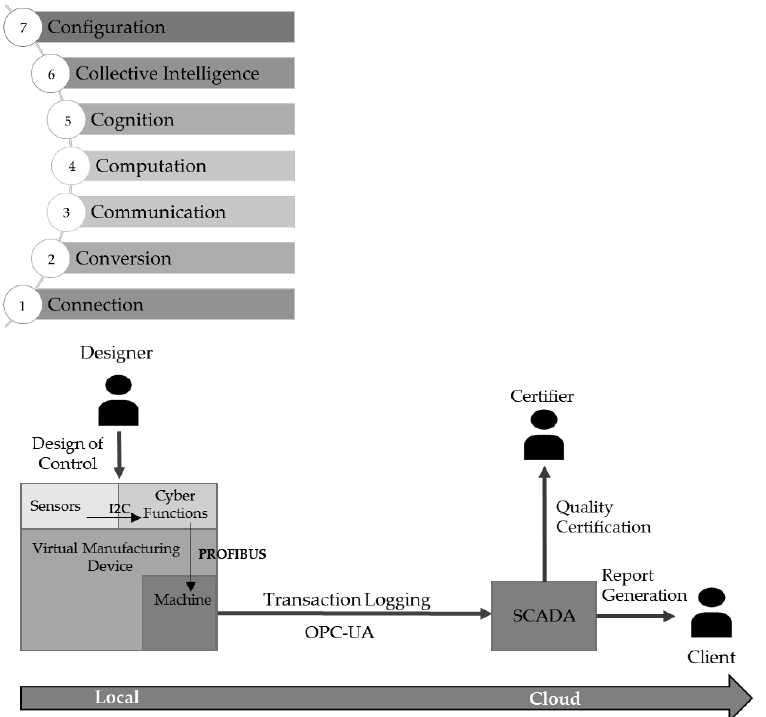
Figure 6. Workflow for process monitoring/control.